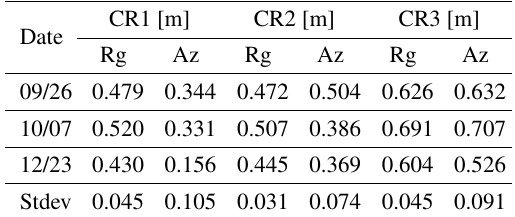
Table 3. Range and azimuth offsets between the expected and the corrected